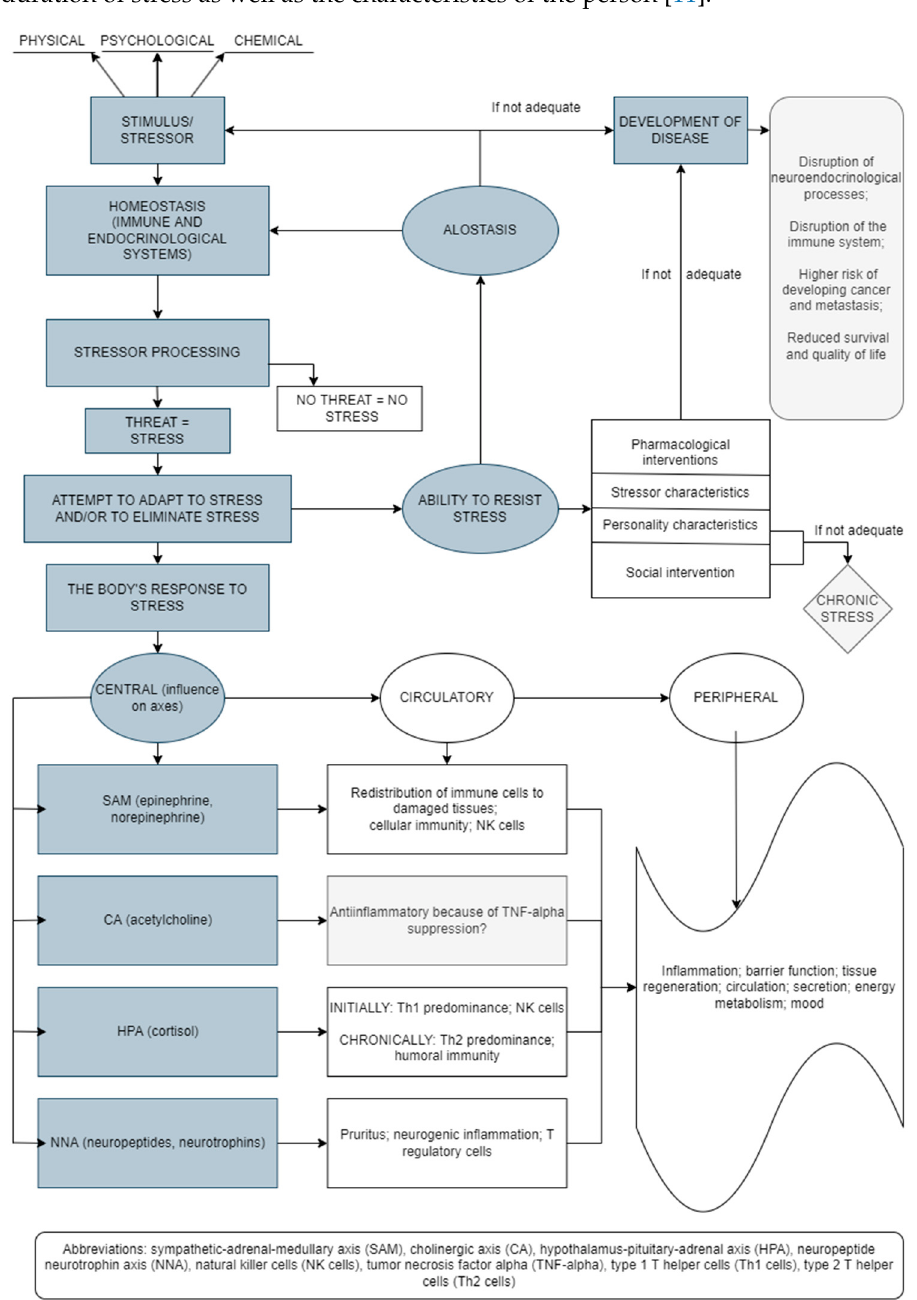
Figure 1. Stress-induced bodily reactions and factors involved in this network (an original scheme based on current literature data).